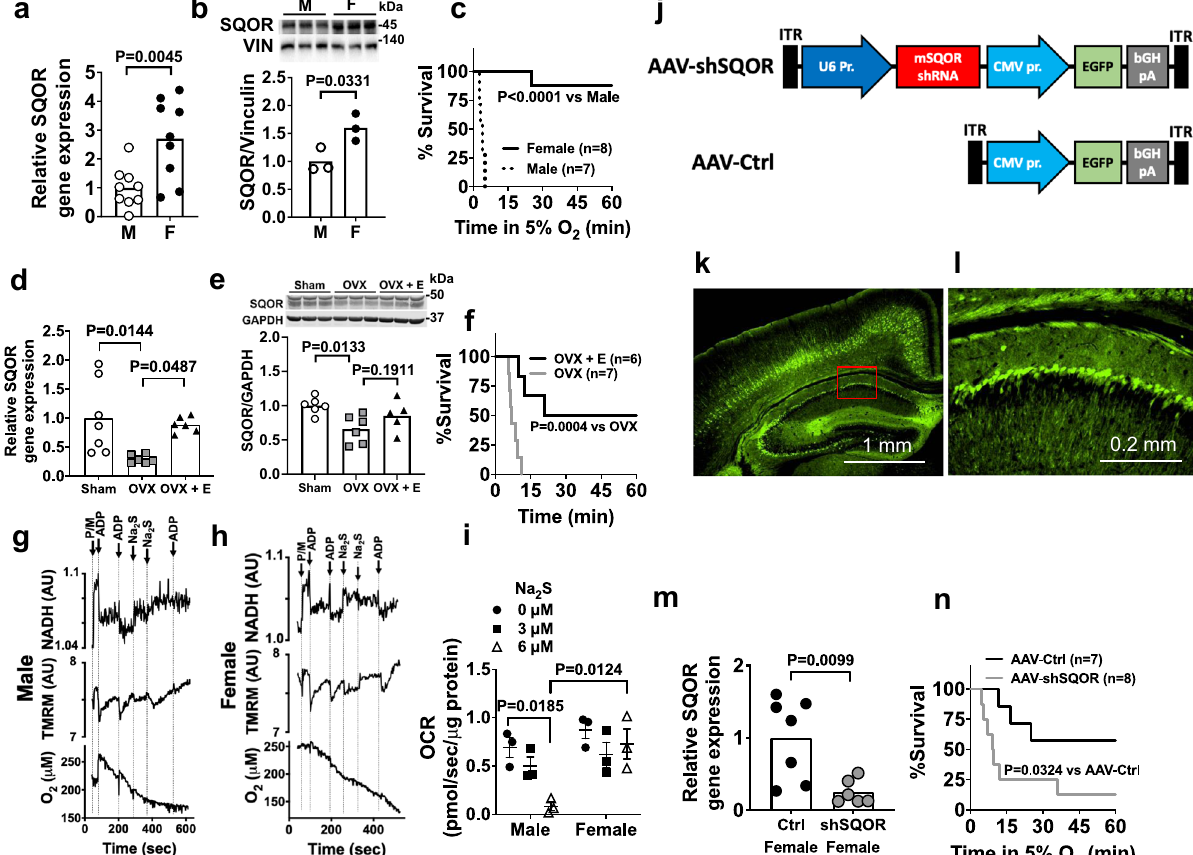
Fig. 2 Sexual dimorphism of SQOR expression in the brain. a Relative SQOR mRNA levels ( n = 9 each) and b protein levels ( n = 3 each) in male and female CD-1 mice. Vin, vinculin. c Survival curve of male and female CD-1 mice breathing 5% oxygen. Effects of ovariectomy (OVX) and 17 beta-estradial (E) replacement on d SQOR mRNA levels ( n = 7, 6, 6) and e protein levels ( n = 6, 5, 5) in the brain and f survival rate in hypoxia (5% O 2 ) in female CD-1 mice. Impact of sul fi de (Na 2 S) on ADP-induced changes in NADH levels, mitochondrial membrane potential (TMRM, tetramethylrhodamine methylester), and oxygen consumption rates (OCR) in suspensions of isolated brain mitochondria from g male and h female WT mice. P/M, pyruvate/malate. Representative traces of three independent experiments in each genotype. i Summary of OCR values in response to ADP before and after administration of sul fi de (Na 2 S, 0, 3, 6 µ M) in experiments represented in g and h . n = 3 at each Na 2 S dose. j Structure of AAV containing shRNA against mouse SQOR (AAV-shSQOR) under a U6 promoter for RNA polymerase III and control AAV (AAV-Ctrl). ITR, inverted terminal repeat, EGFP, enhanced green fl uorescent protein, CMV, cytomegalovirus, bGH, bovine growth hormone. k , l Representative immuno fl uorescence images of the brain sections of CD-1 mice stained with an anti-GFP antibody 8 weeks after injection of AAV-Ctrl into ICV. Image in l shows a blow-up of a part of the image in k enclosed in a red box. n = 2 biologically independent experiments. m Relative SQOR mRNA levels in the brains of female CD-1 mice transfected with AAV-Ctrl or AAV- shSQOR ( n = 7, 6). n Survival curve of adult female CD-1 mice infected with AAV-Ctrl or AAV-shSQOR breathing 5% oxygen. Data are presented as mean ± SEM or mean and individual values. A two-tailed unpaired t -test was performed for a , b , and m . Survival rates were estimated using the Kaplan – Meier method and a log-rank test was used to compare the survival curves between groups in c , f , and n . One-way or two-way ANOVA followed by Dunnett ’ s or Tukey ’ s correction for post-hoc comparisons were performed for d , e , and i ratio of NADH/NAD + in whole-brain tissue homogenates (Fig. 3j, of neurons in hypoxia, we isolated primary cortical neurons from k and Supplementary Fig. 6c). Although breathing 5.5% O 2 for 3 min increased levels of sul fi de and persul fi de and the ratio of Sqor Δ N/ Δ N and WT littermate embryos. Sqor Δ N/ Δ N neurons had higher levels of intracellular sul fi de compared to WT neurons NADH/NAD + in the brains of both genotypes, sul fi de levels and (Fig. 3h), suggesting that SQOR has a critical role in the catabolism the ratio of NADH/NAD + were higher in the brains of Sqor Δ N/ Δ N of sul fi de in neurons even under normoxic conditions. In addition, mice than in control mice. In contrast to the results observed in the the magnitude of the oxygen and glucose deprivation (OGD)- brains of WT mice, breathing 5.5% O 2 did not affect the levels of induced increase in sul fi de levels was markedly greater in Sqor Δ N/ sul fi de and persul fi de or the ratio of NADH/NAD + in the heart or Δ N compared to WT neurons. Reoxygenation after OGD decreased liver of WT mice (Fig. 3l-o and Supplementary Fig. 6d). However, exposure to 5.5% O 2 increased these metrics in the heart and liver of cell viability more markedly in Sqor Δ N/ Δ N than in WT neurons Sqor Δ N/ Δ N mice. These results indicate that mitochondrial SQOR (Supplementary Fig. 6b). Compared to 5-week-old WT mice, prevents the accumulation of sul fi de and persul fi de and decreased Sqor Δ N/ Δ N littermates had a shorter survival when exposed to 5.5% oxidative phosphorylation induced by hypoxia not only in the brain O 2 (Fig. 3i). When Sqor Δ N/ Δ N and control mice breathed air, there but also in the heart and liver. were no differences in the levels of sul fi de and persul fi de or in the